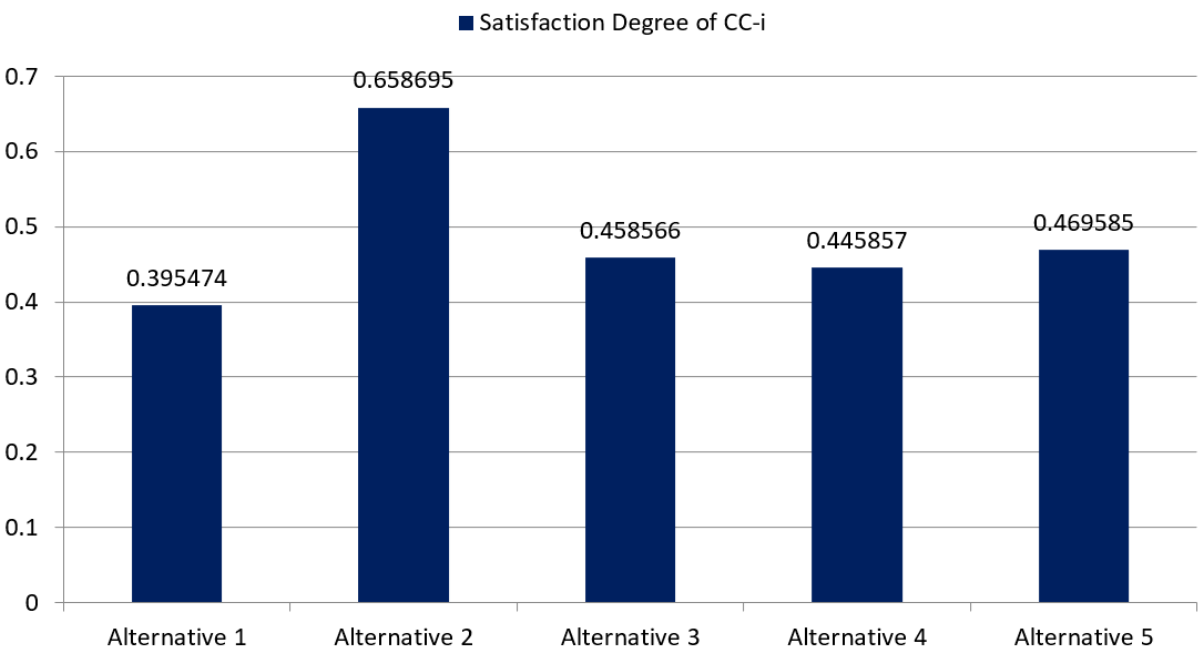
Figure 4. Satisfaction Degree of CC-i .